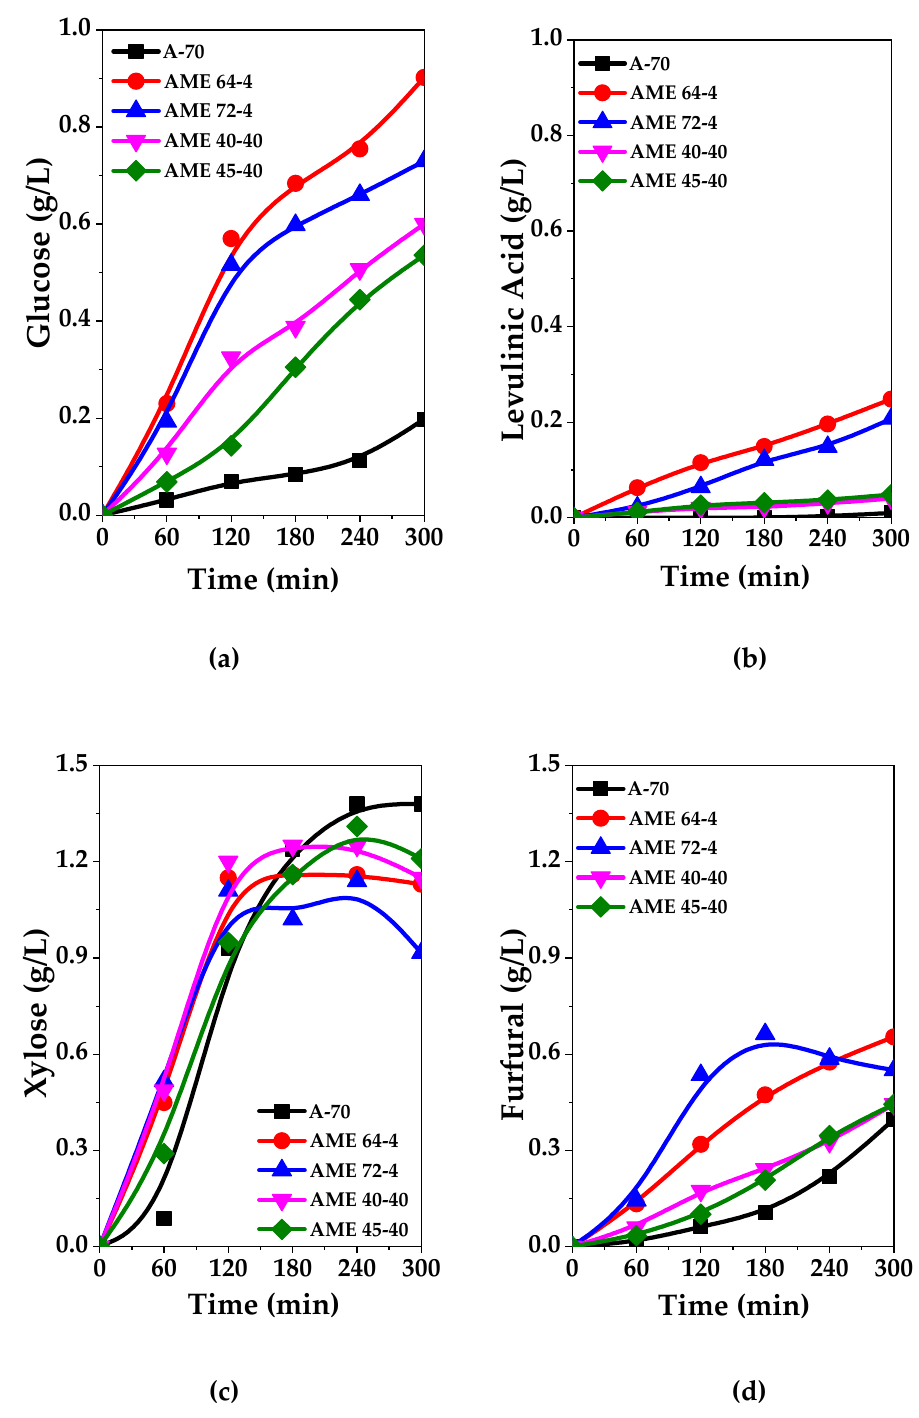
Figure 9. The concentration of ( a ) glucose, ( b ) levulinic acid, ( c ) xylose and ( d ) furfural over time in the hydrolysis of wheat straw catalyzed by the AME materials at 140 °C.